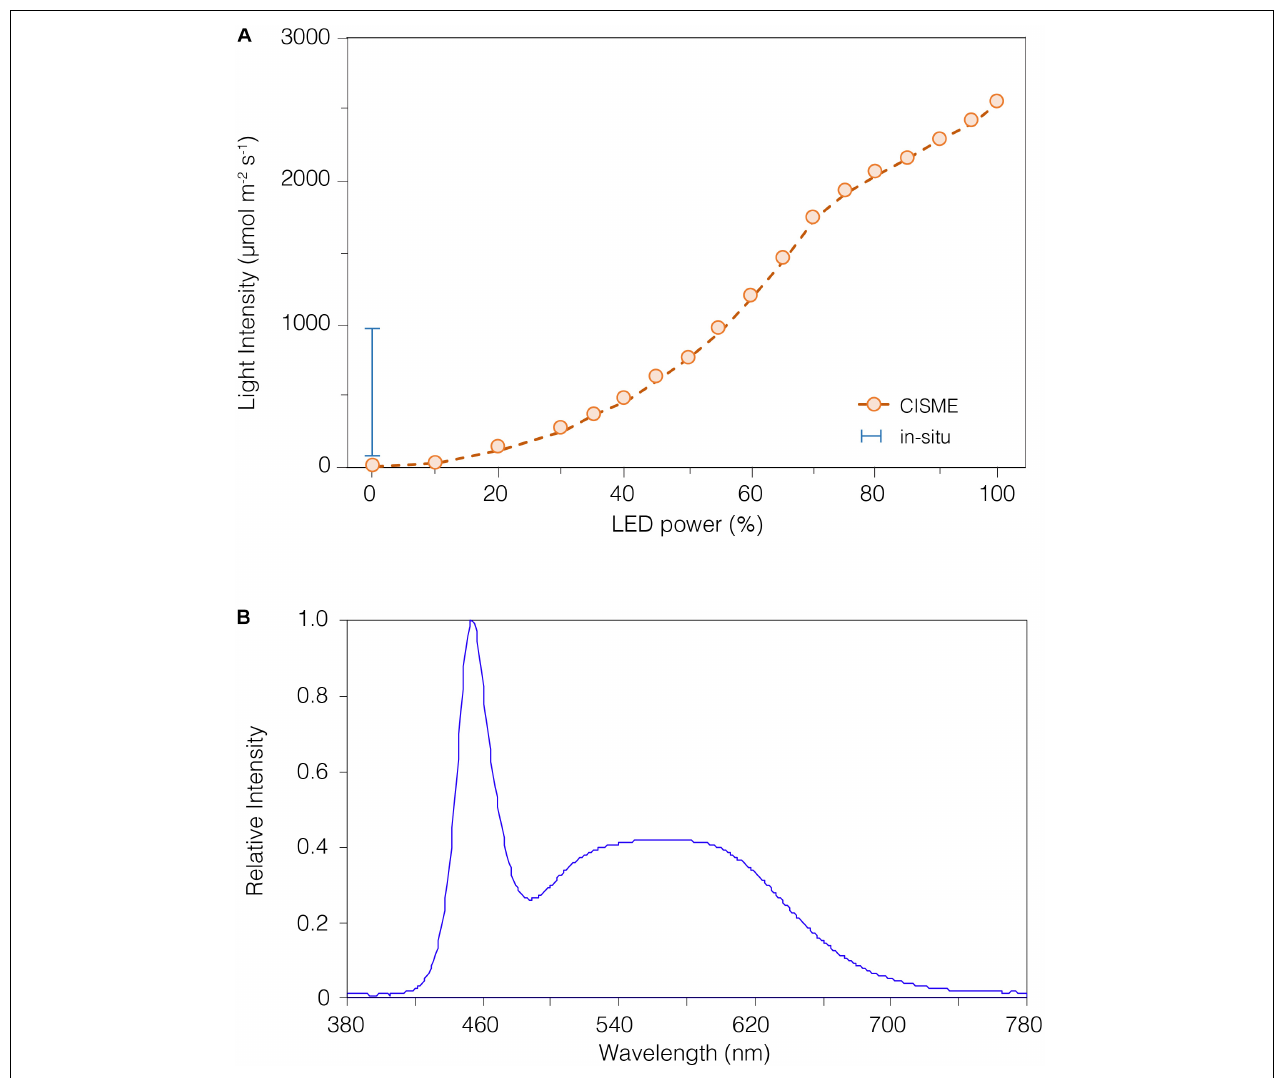
FIGURE 3 | The light intensity of the LED array can be regulated by altering the input power. (A) The non-linear relationship between LED power and light intensity (open circles), as measured using a LiCor light-meter. The light intensity can be adjusted up to ∼ 2500 µ mol m - 2 s - 1 , or near maximal levels of natural light at sea level. Daily in situ light levels measured with a HOBO logger are depicted by the range bar for reference. The in situ light was measured by the HOBO logger during an 18-month survey and showed a median of ∼ 410 µ mol m - 2 s - 1 , which was the level selected for our study. (B) The LED array emitted a light at 380–780 nm, as measured in sub-aerial conditions with a UPRTrek LED-meter. The highest peak was recorded at 450 nm (violet-blue light), and the color temperature recorded was 7000 ◦ K (Luxeon warm white). While the shape of this spectrum differs from natural sunlight, it encompasses the range of photosynthetically active radiation (PAR) and has very limited contribution from damaging UV ( < 400)